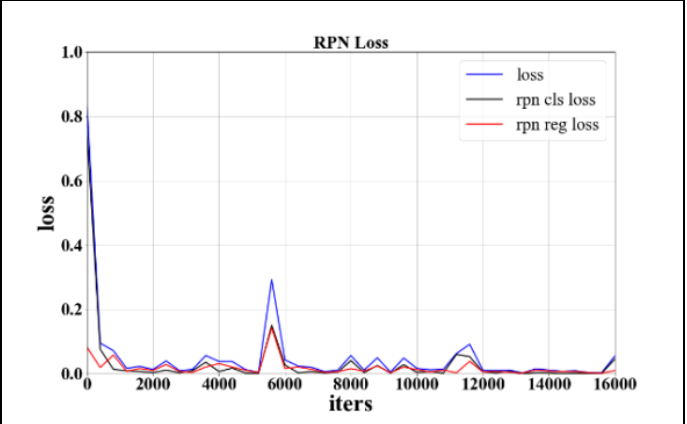
Figure 12. Loss function curve of RPN process.